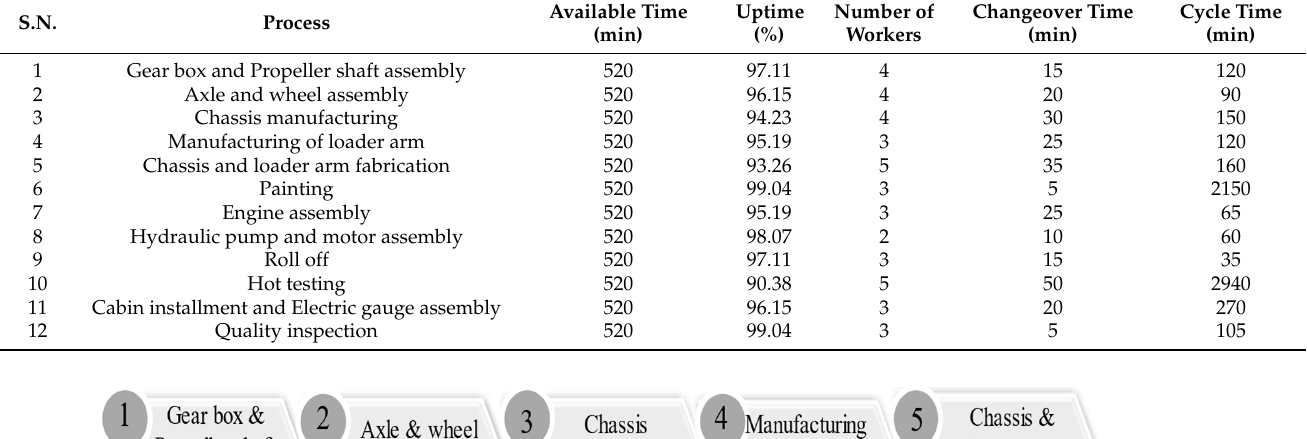
Table 5. Production parameters obtained in modified shop floor.